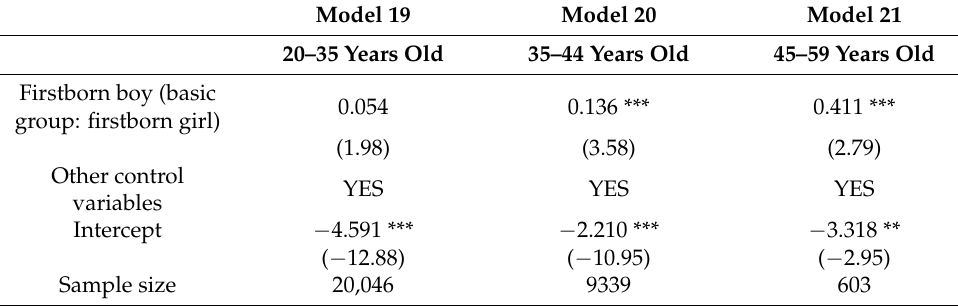
Table 8. Overwork of migrant women in different age